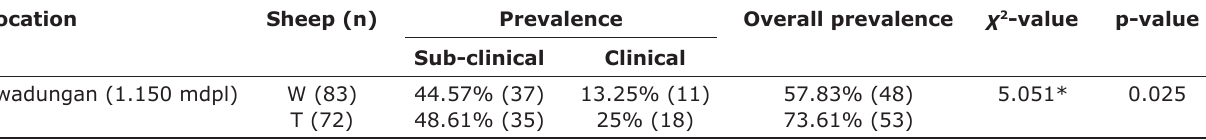
Table-4: Prevalence of clinical and sub-clinical gastrointestinal nematodiasis parasites infestation in Wonosobo and thin-tailed sheep in Kwadungan village. Location Sheep